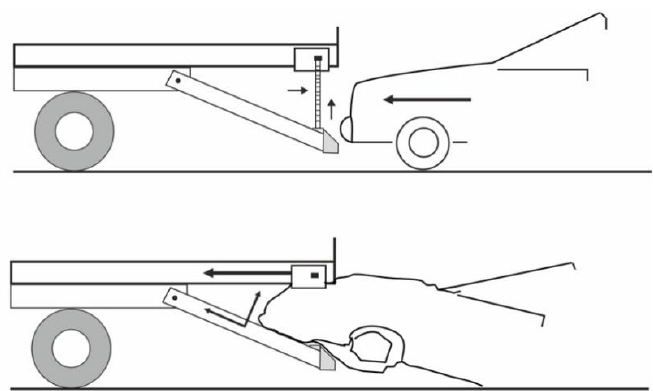
Figure 9. View of the RUPD named “Plier under - ride guard”.